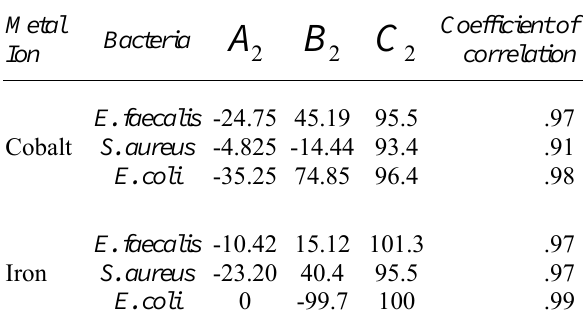
Table 3: Coefficients of mathematical models (equation